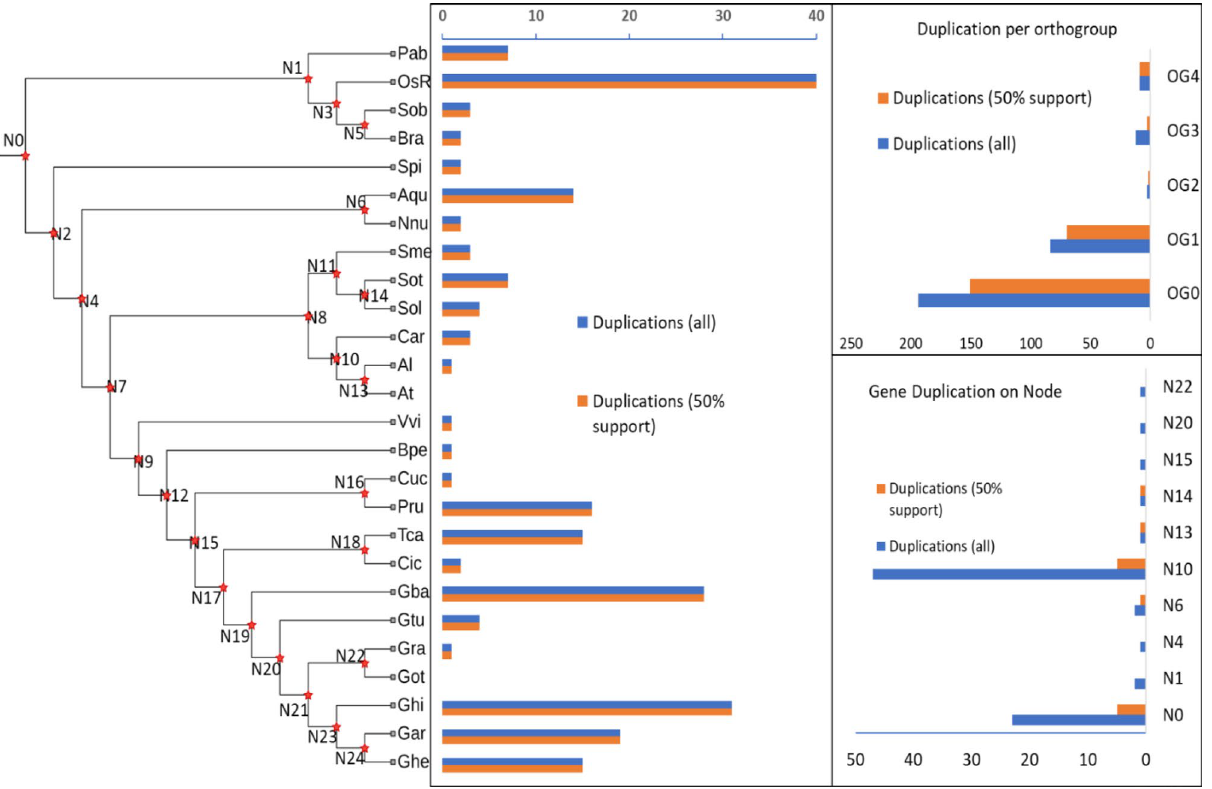
Figure 3. Evolutionary summary; species-tree with duplication events at the terminal and internal nodes and duplication at orthogroup